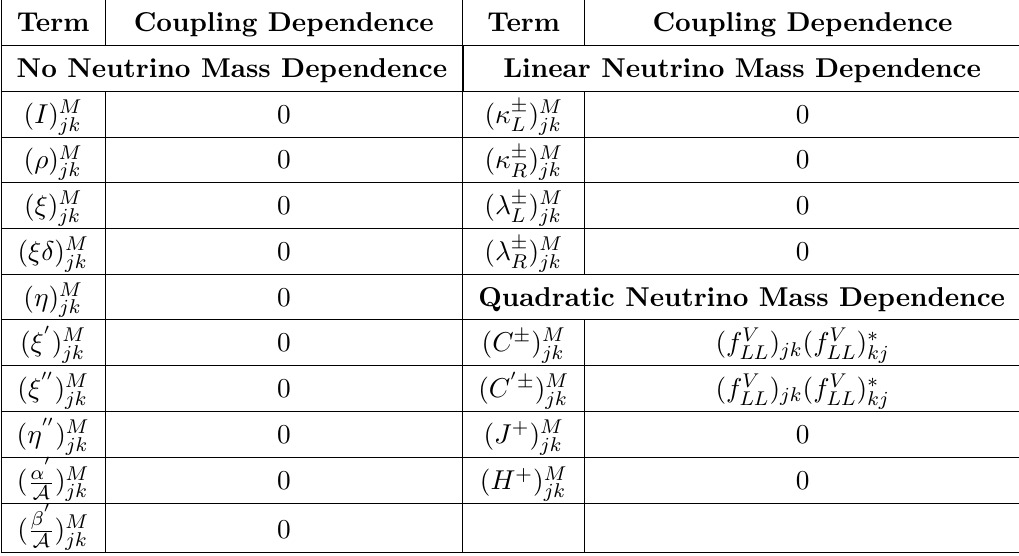
Table 7. SM Case | f V